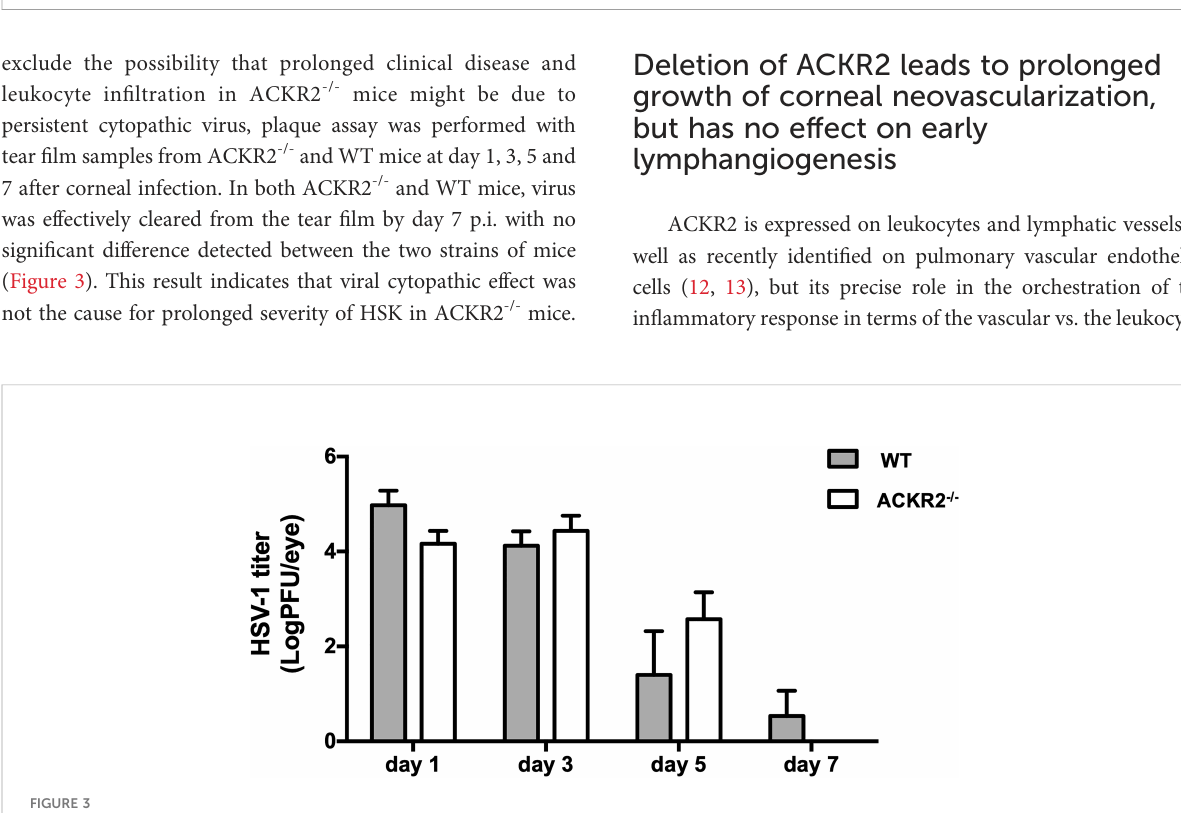
BA FIGURE 2 Leukocyte in fi ltration is increased in ACKR2 -/- HSV-1 infected corneas. HSV-1 infected corneas were harvested from ACKR2 -/- and WT mice post corneal infection and stained with CD45, CD3, CD11b and Gr-1 for fl ow cytometry analysis. (A) Gating strategy for corneal leukocyte in fi ltration. CD3, CD11b and Gr-1 subpopulations were gated under CD45 positive population. (B) Leukocyte in fi ltration in infected corneas of ACKR2 -/- (clear circle) and WT ( fi lled circle) mice at day 5 and day 7 p.i. Control corneas were collected from untreated ACKR2 -/- and WT mice. N = 4-5. Statistical analysis performed with Mann-Whitney U test with * p < 0.05. Data are representative of two independent sets of experiments shown as mean ±